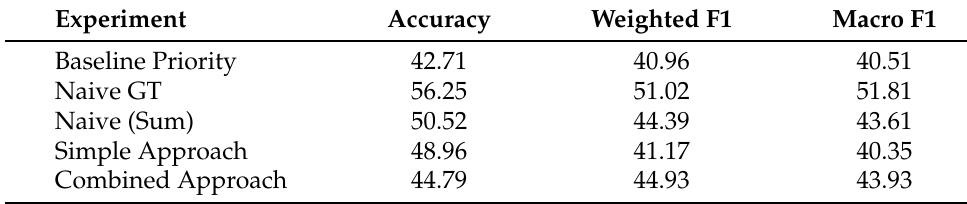
Table 13. Global metrics score of test set 2 for final priority level prediction (in %).